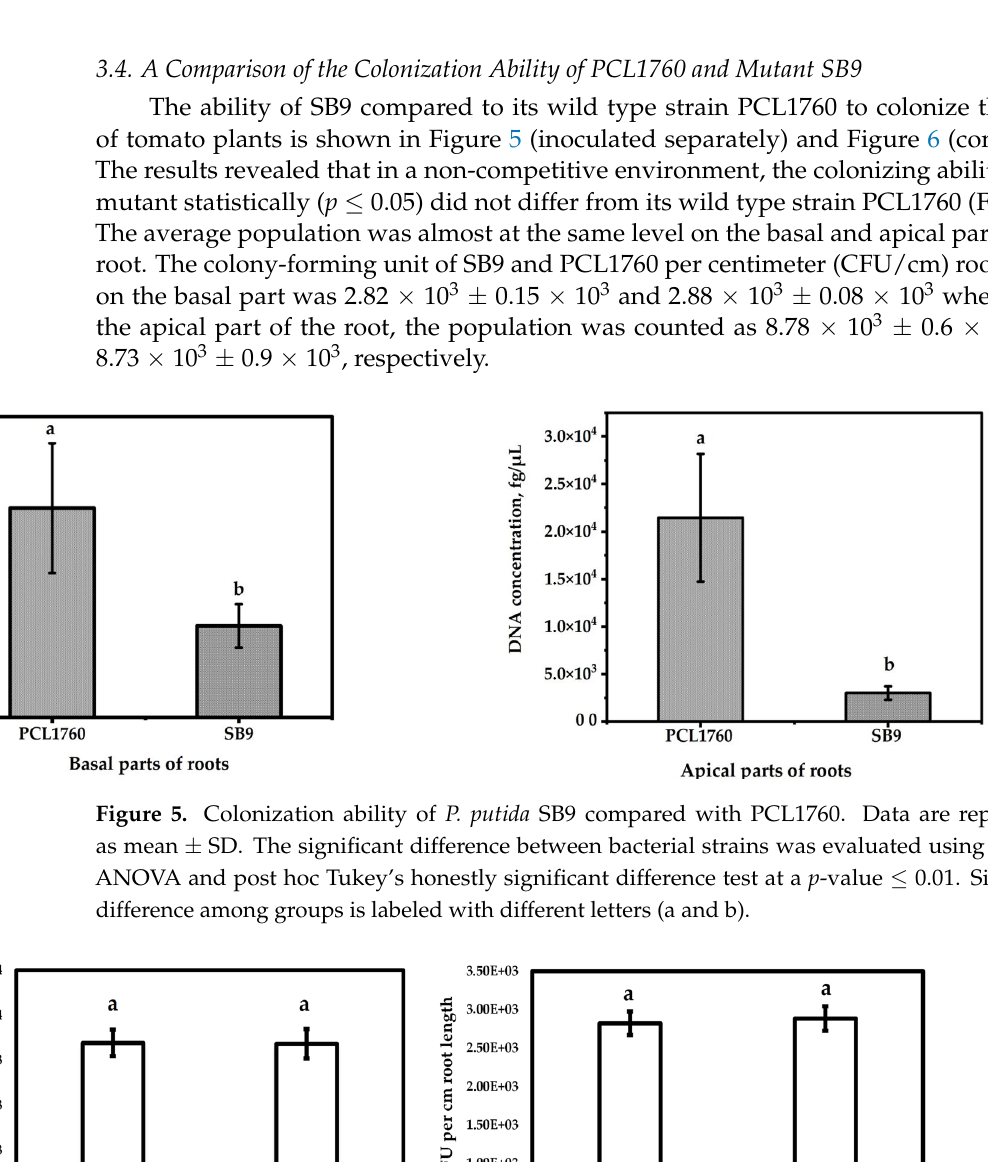
Figure 4. Growth curve comparison of P. putida SB9 and PCL1760 in a rich LB medium ( A ) and a basal medium ( B ). Data are represented as mean ± SD.